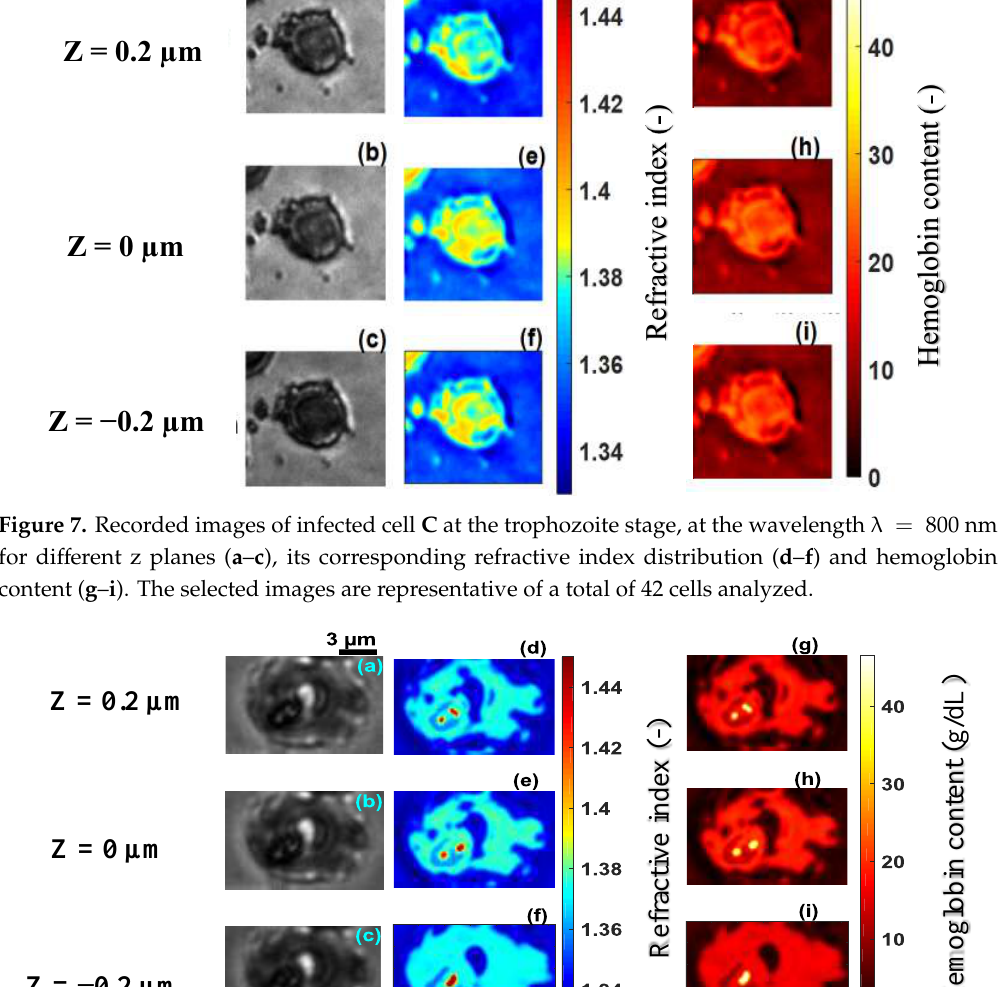
Figure 9. Recorded images of infected cell E at the schizont stage, at the wavelength λ = 800 nm for different z planes ( a )–( c ), its corresponding refractive index distribution ( d )–( f ) and hemoglobin content ( g )–( i ). The selected images are representative of a total of 28 cells analyzed.